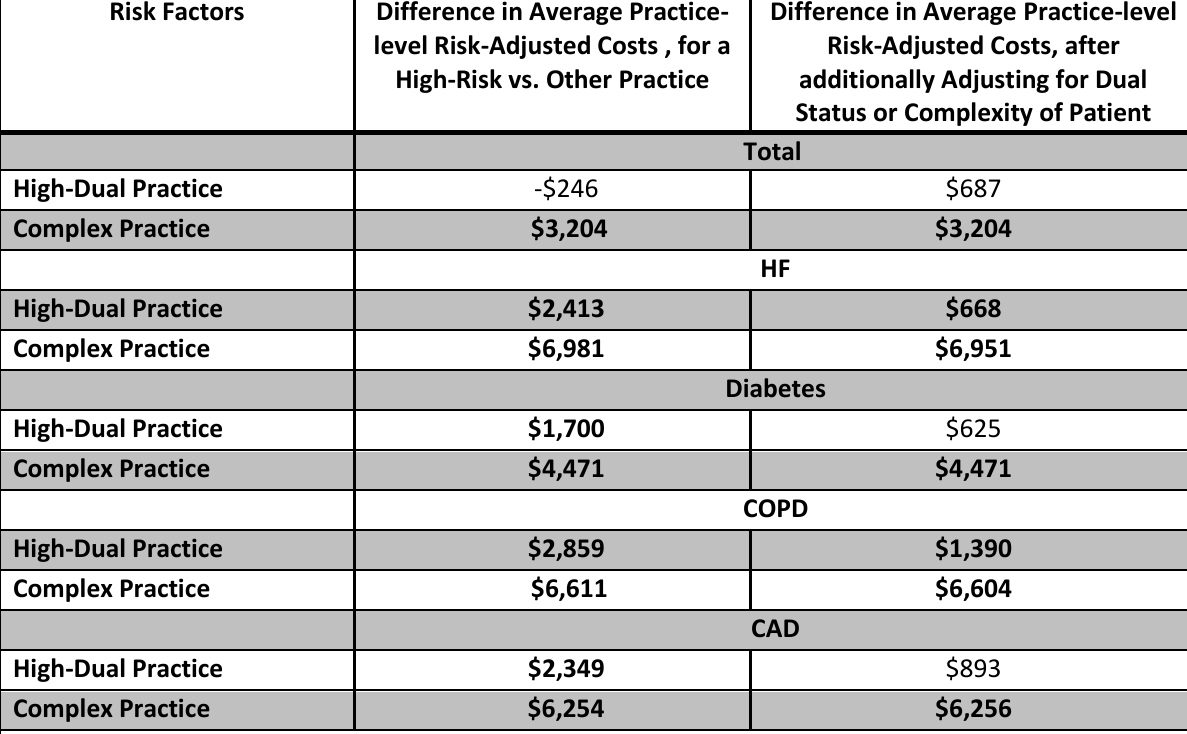
Table 10.10. Practice Factors in Per Capita Cost Measures Risk Factors Difference in Average Practice- level Risk-Adjusted Costs , for